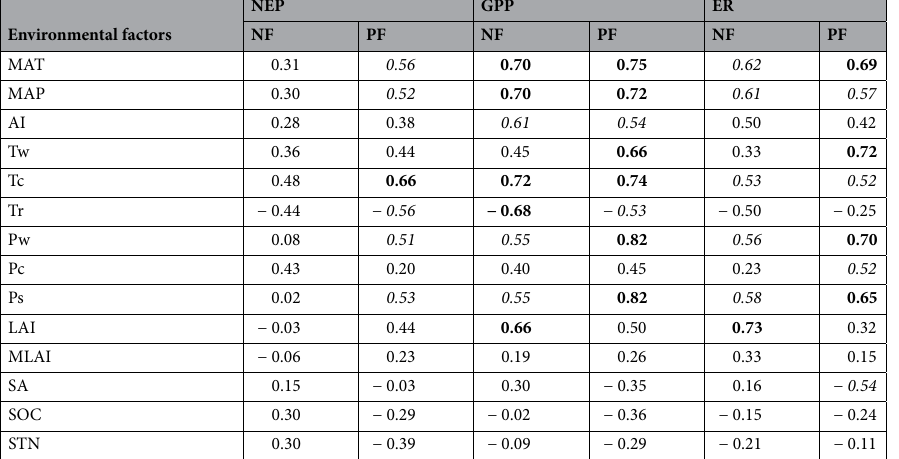
Table 1. Correlation coefficients between carbon fluxes and environmental factors in naturally regenerating forests (NF) and planted forests (PF). Carbon fluxes include net ecosystem productivity (NEP), gross primary productivity (GPP), and ecosystem respiration (ER). The abbreviations of the environmental factors are the same as those in the legend of Fig. 1. Italics and bold indicate significant correlation coefficients at α = 0.05 and α = 0.01, respectively.